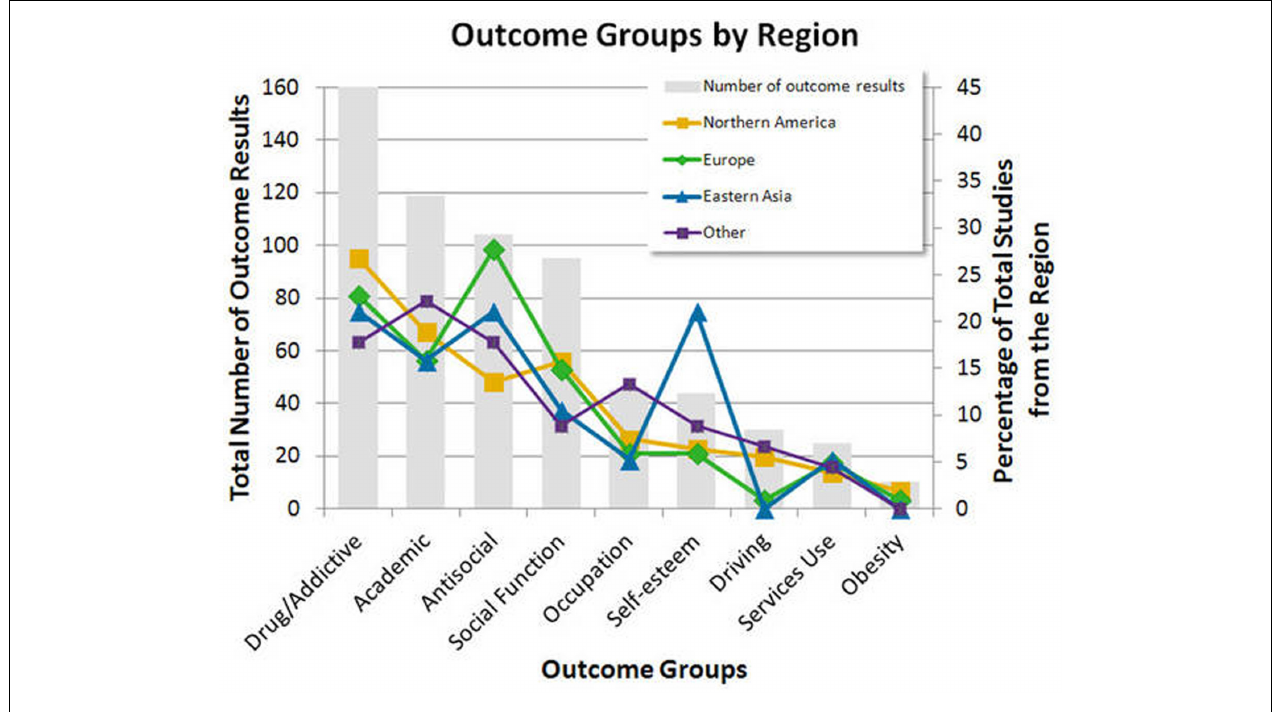
examined antisocial behavior; in Northern America non-medicinal drug use/addictive behavior; and in Eastern Asia self-esteem, non-medicinal drug use/addictive behavior, and antisocial behavior.The highest proportion of studies from all other regions together focused on academic